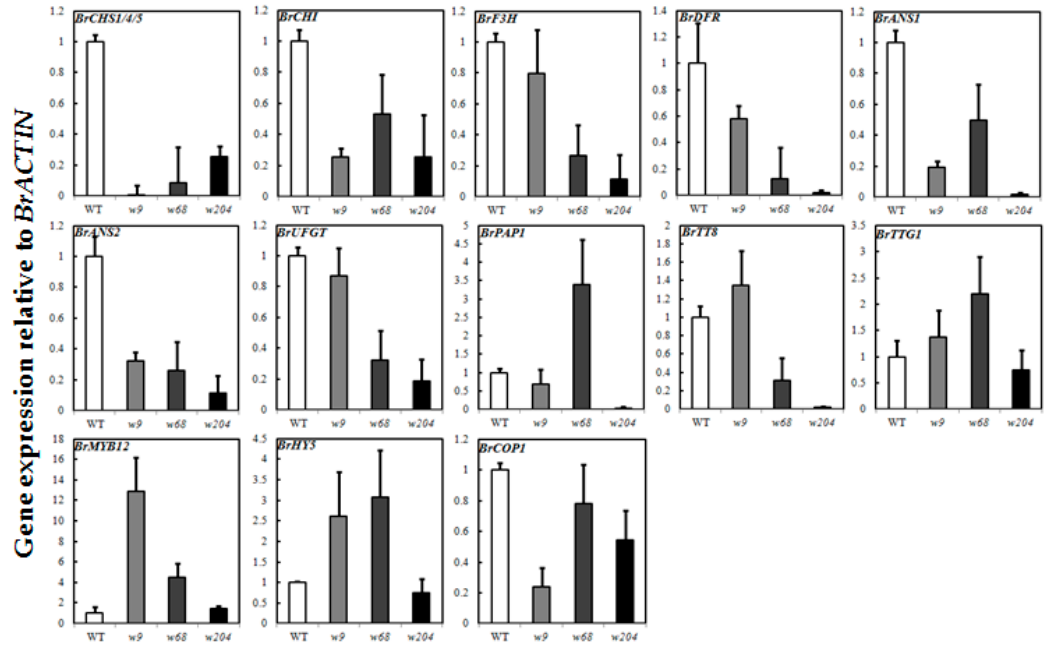
Figure 8. Expression analysis of anthocyanin biosynthesis genes and light responsive genes in light-exposed swollen root peels of white mutants and WT. The expression value for each sample was normalized to that of the BrACTIN gene, and the transcript level in light-exposed epidermis of swollen roots of WT was set as 1.0. The expression levels of w9 (gray column), w68 (dark gray column) and w204 (black column) were compared to WT (white column). The mean values of three technical replicates are shown with error bars (SD).